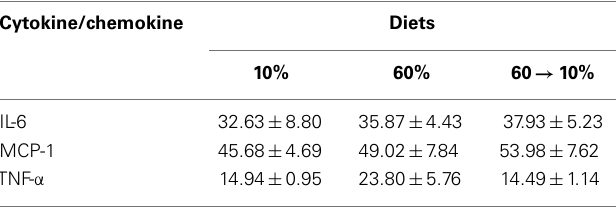
Table 1 | Systemic changes in inflammatory cytokines and chemokines were not evident